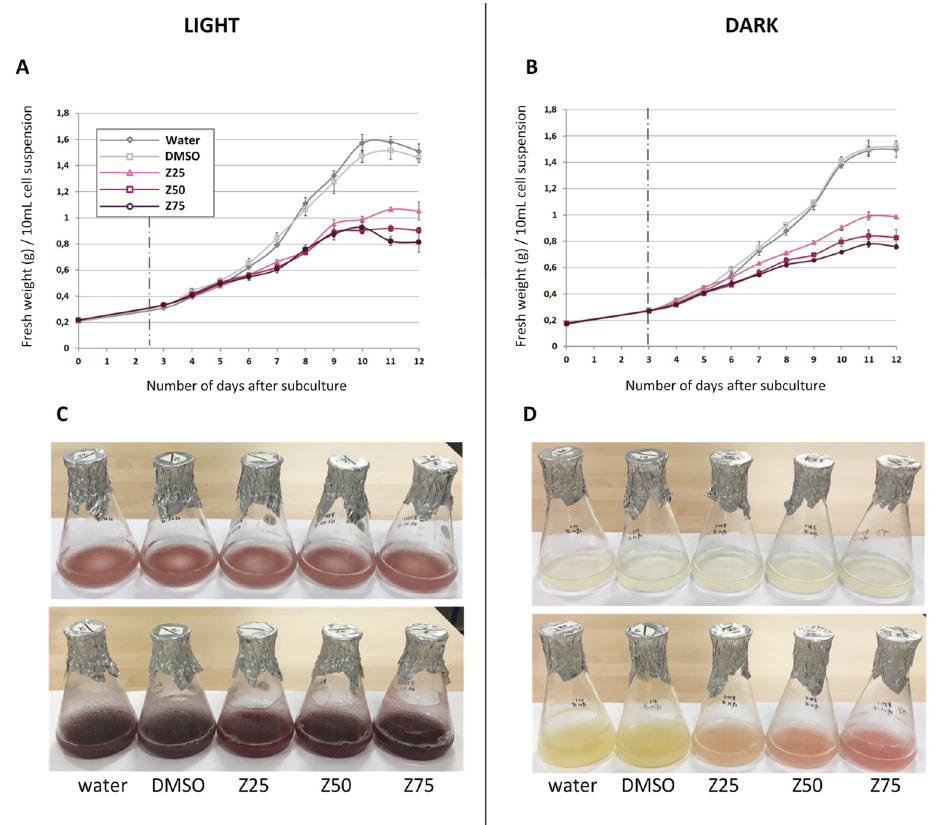
Figure 2. Zebularine affects GT cell growth and anthocyanin accumulation. Treatment with zebularine was performed 3 days after sub-culturing, in the light ( A , C ) and in the dark ( B , D ), using three concentrations 25 µM (Z25), 50 µM (Z50), and 75 µM (Z75). Two different controls were included (water and DMSO). Growth curves ( A , B ) were established by measuring the fresh weight of 10 mL samples after vacuum filtration each day after the sub-culture (day 0) until day 12. The values represent the means of three biological replicates and the bars the corresponding standard deviations. Photographs were taken at the first day (0 day) (upper pictures) and last day (12th day) (lower pictures) after sub-culturing ( C , D ).